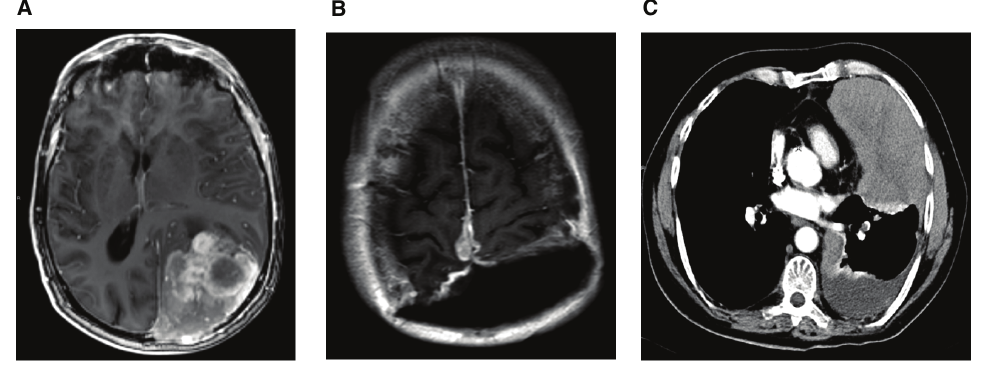
Figure 1. MRI and CT scanning of the original meninigioma intra-cerebral and at distance metastasis intra-pleural. A : T1 weighted image after administration of Gadolinium based contrast fluid shows a large extra-axial enhancing lesion in the left parieto-occipital region with local mass effect. Note that the sagittal sinus seems to be invaded. B : Contrast enhanced T1 weighted image after administration of Gadolinium based contrast fluid showing a large resection cavity after the second operation and recurrent disease at the most upper margin of the resection plane with enhancing areas surrounding the sagittal sinus. C : Midthoracal CT slice in the transverse plane. Scan performed after i.v. administration of iodine contrast. The lesion is easily distinguished at the left ventral thoracal intrapleural space, slightly enhanced suggesting solid tissue. Some pleural fluid is also